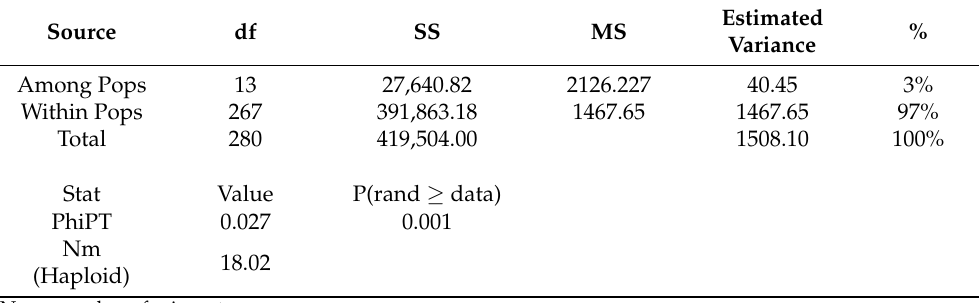
Table 3. Analysis of molecular variance (AMOVA) for 281 soybean germplasms based on DArT markers. Source df SS MS Among Pops Within